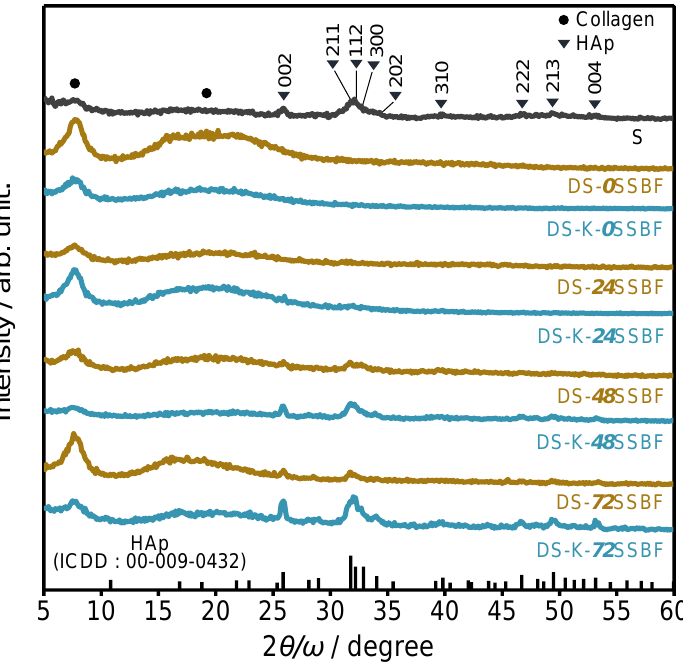
Figure 2. XRD patterns of the scales before and after the immersion in SSBF (incident degree ( ω ) of X-ray: 0.5°).